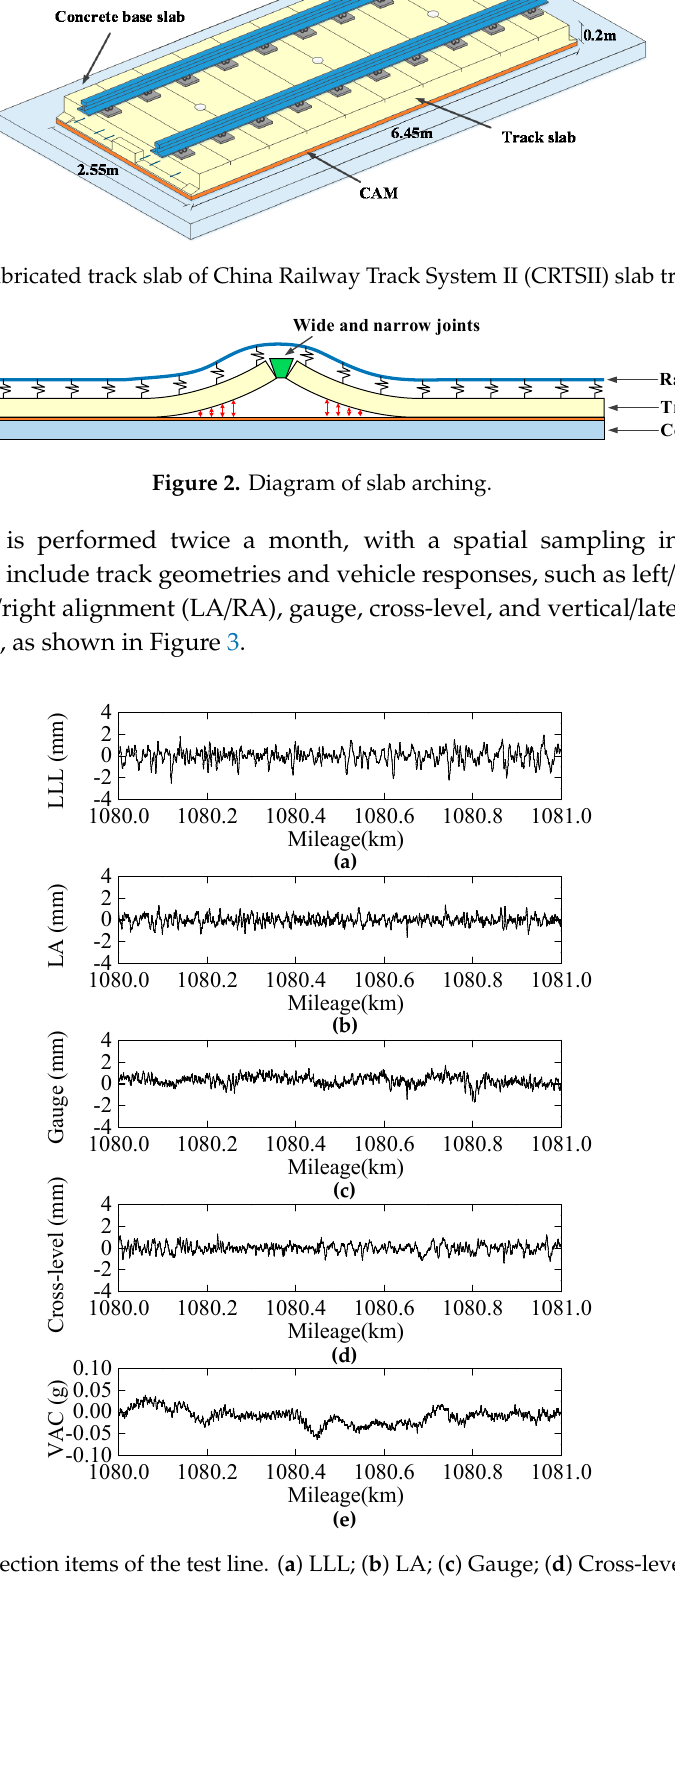
Figure 1. Prefabricated track slab of China Railway Track System II (CRTSII) slab track system.